Question: What kind of plot is shown here?
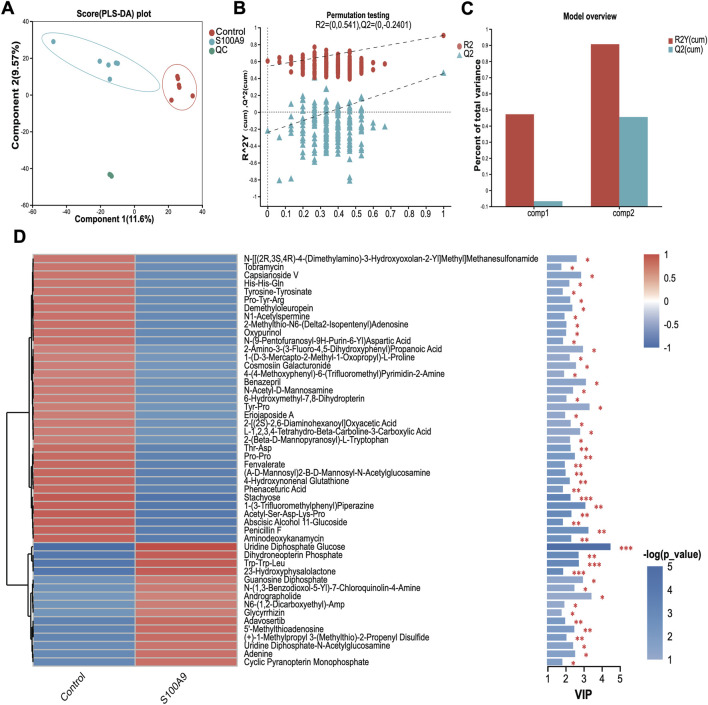
Answer: heatmap